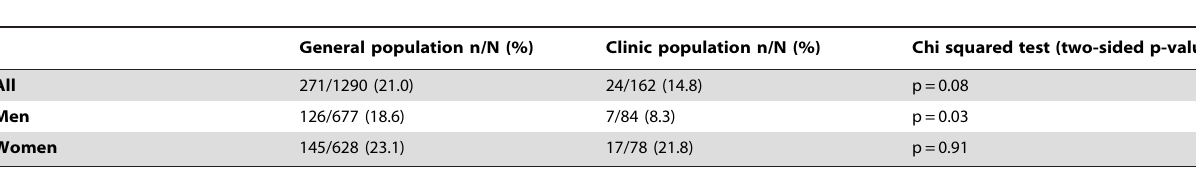
Table 3. HIV prevalence general population of Thyolo District and clinic